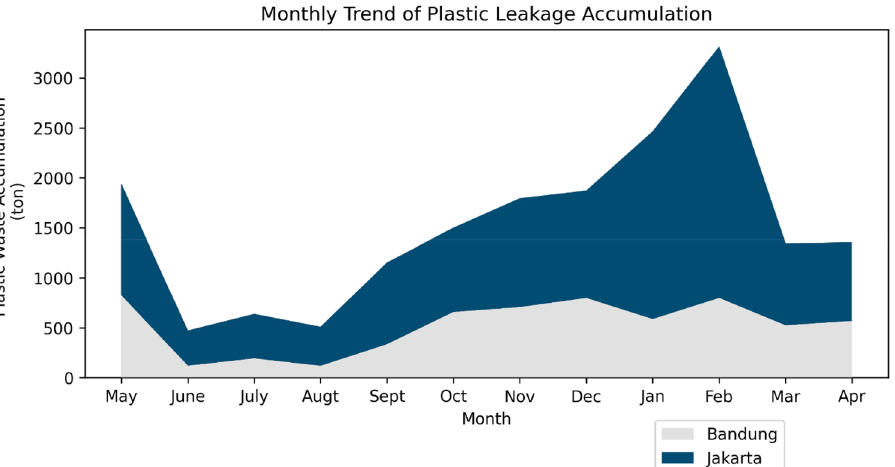
Figure 5. Monthly plastic leakage accumulation in DKI Jakarta and Bandung City modelled for year 2020 to 2021.